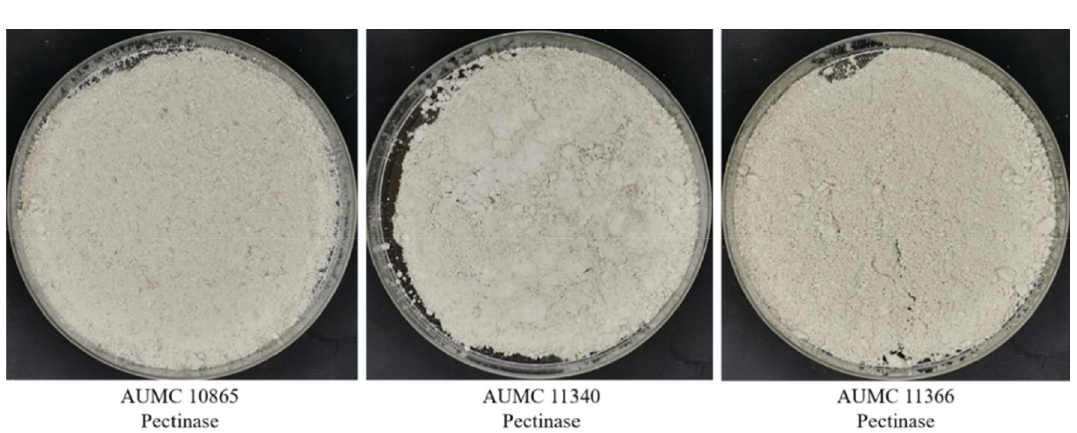
Figure 13. Pectinases powder produced by Cladosporium strains in SmF.